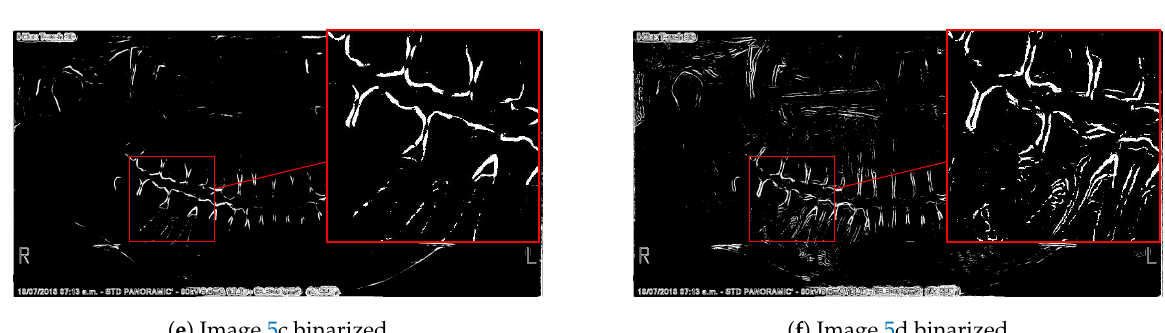
Figure 5. Application of an edge detection algorithm on an image preprocessed with